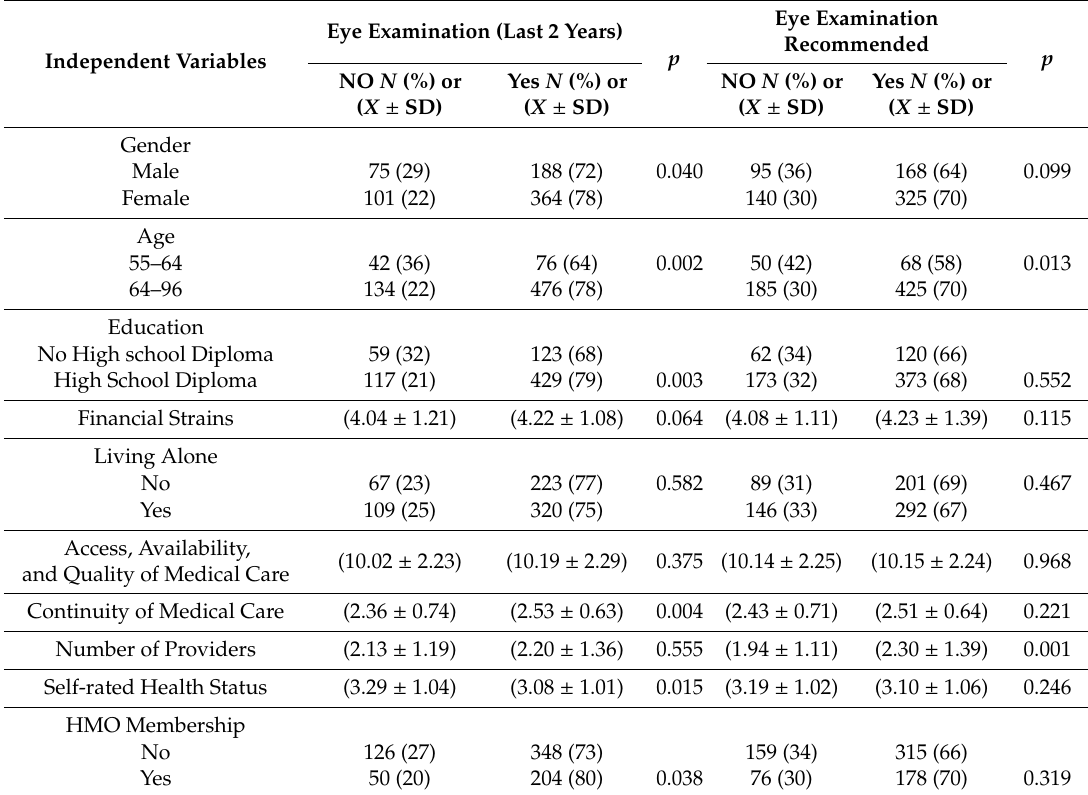
Table 2. Bi-variate correlates of eye examination and eye recommendation among underserved middle-aged and older African-American adults ( n =